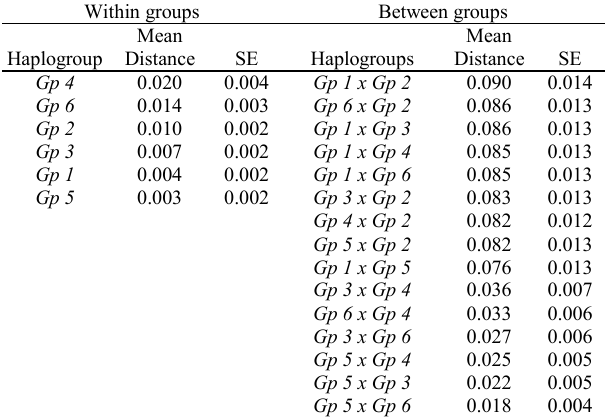
Table 4. Mean genetic distances of Hoplias malabaricus haplogroups estimated by Kimura-2-parameter algorithm adjusted with Gamma shape parameter = 1.00. Standard Error